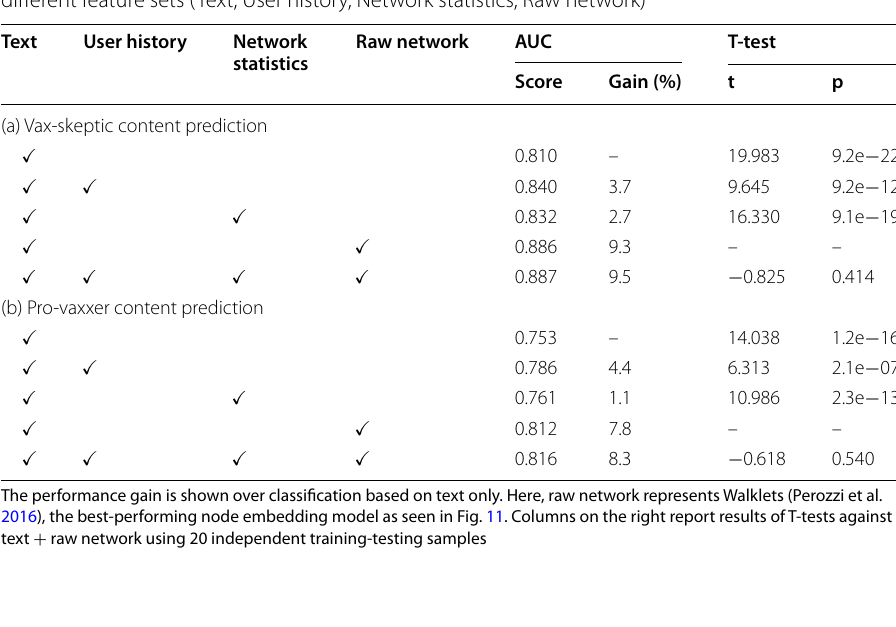
Table 4 Model performance (AUC) for both vax-skeptic and pro-vaxxer content prediction with different feature sets (Text, User history, Network statistics, Raw network)